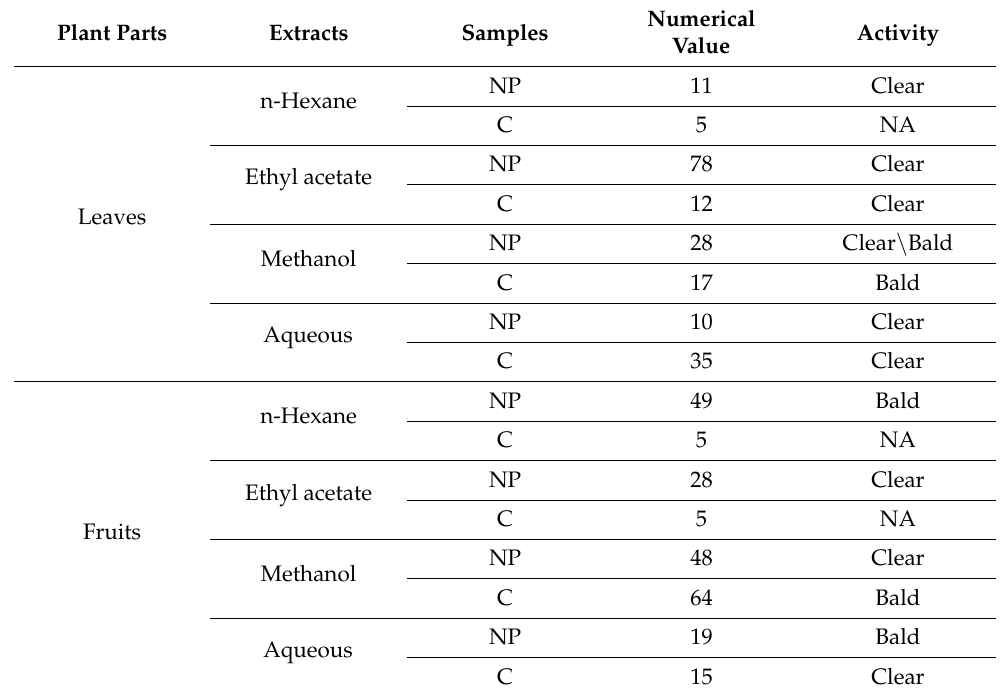
Table 5. Protein kinase inhibition of crude extracts and nanoparticles of leaves and fruits of C. colocynthis .